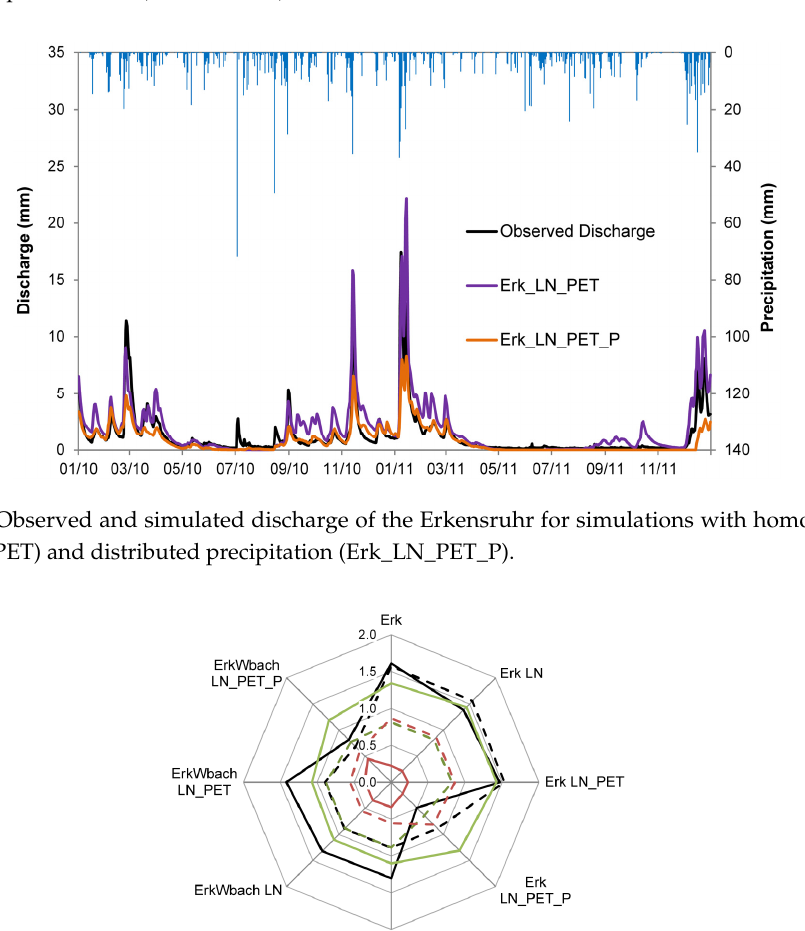
Figure 6. Observed and simulated discharge of the Erkensruhr for simulations with heterogeneous soil data (Erk), heterogeneous soil and land use data (Erk_LN), heterogeneous soil, land use and potential evapotranspiration data (Erk_LN_PET).